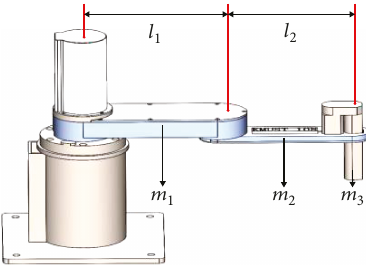
Figure 1: 2-DOF SCARA robot